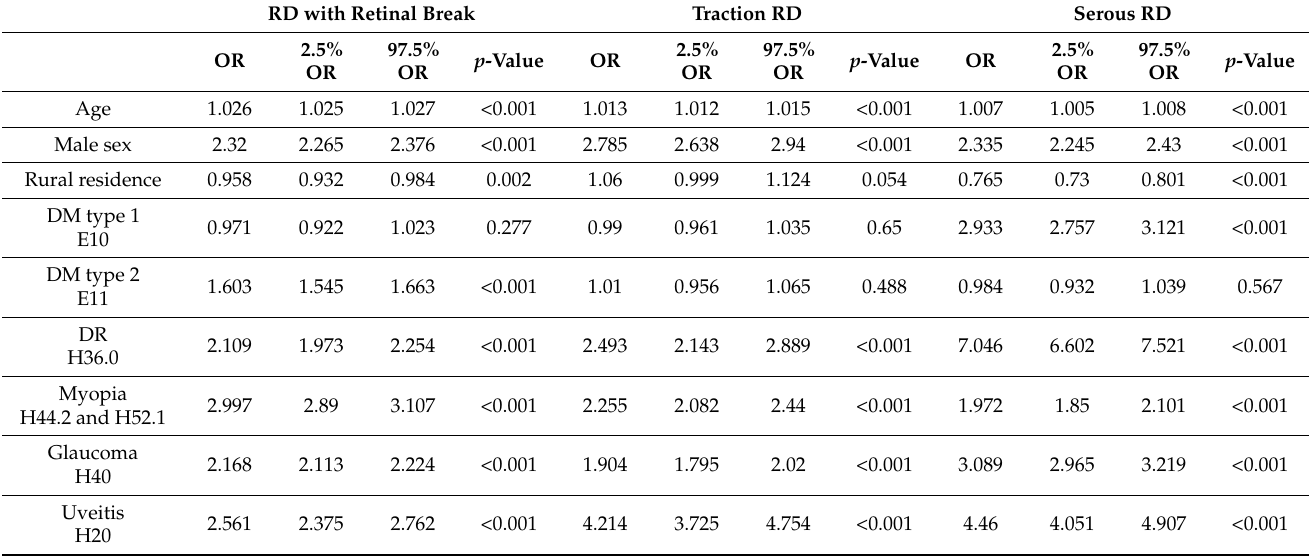
Table 4. Multiple logistic regression models of the risk factors for different types of RD among Polish adults from 2013 to